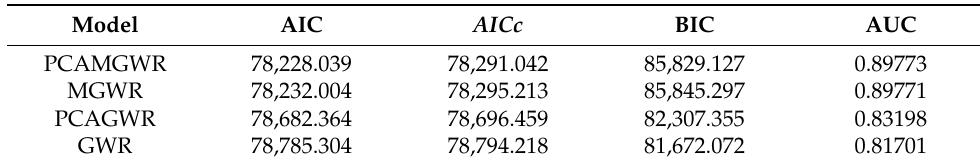
Table 3. Accuracy statistics of models.